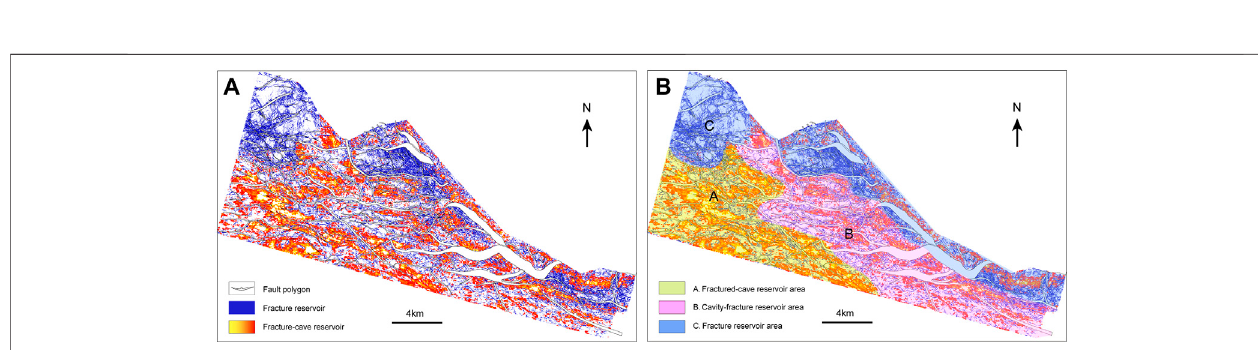
FIGURE9 |(A) Overlap map of theburied-hillreservoirs inthe BC block (0 – 100 m belowthe buried hill surface). (B) Planar distribution of thethree types ofburied- hill reservoirs in the BC block (0 – 100 m below the buried hill surface).